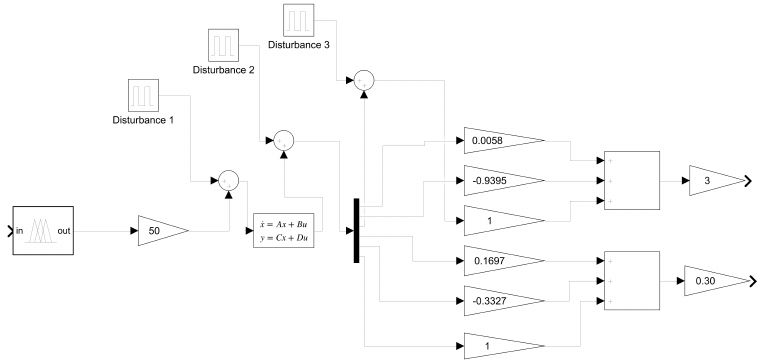
Figure 27. The external repetitive disturbances in